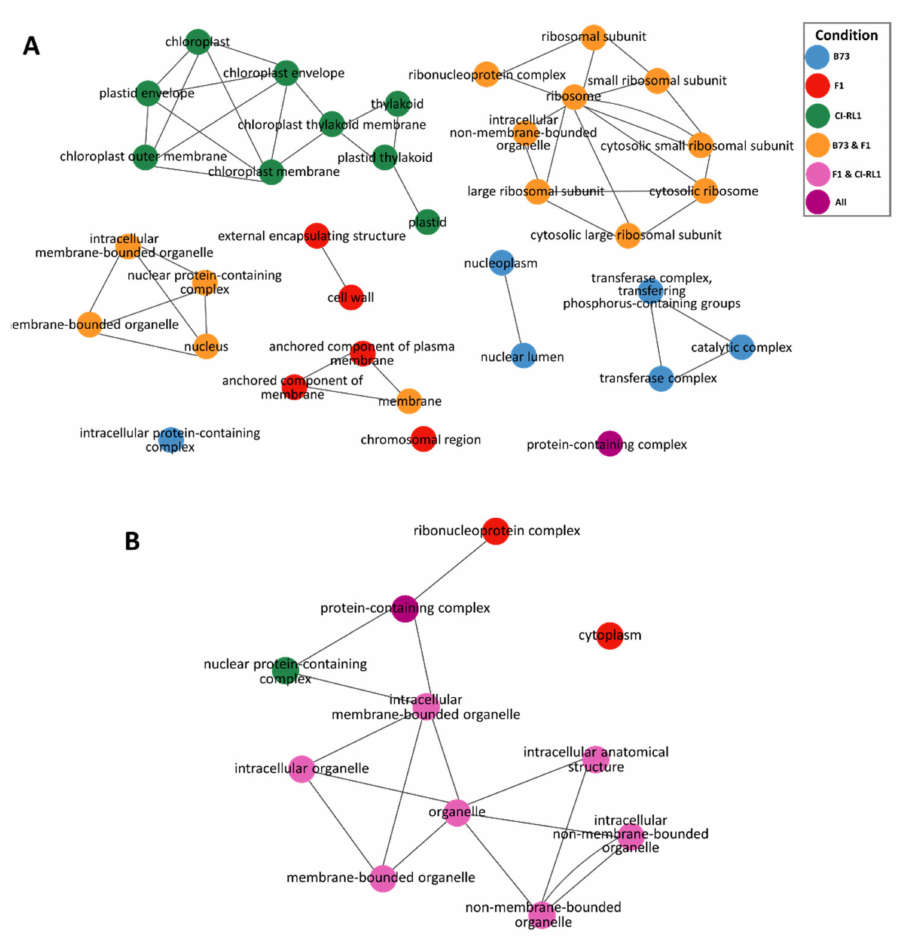
Figure 4. Functional enrichment network of cellular components (CCs) of differentially expressed genes (DEGs) in B73, CI-RL1, and F1 progeny. ( A ) Enrichment network of upregulated ( B ) and downregulated genes. Nodes represent an enriched CC ontology term, and edges represent the relationships between these ontologies. CC shared terms correspond to the following: B73 alone (blue); shared between B73 and F1 (orange); shared between all lines (purple); shared between CI-RL1 and F1 (pink); and those corresponding to CI-RL1 alone